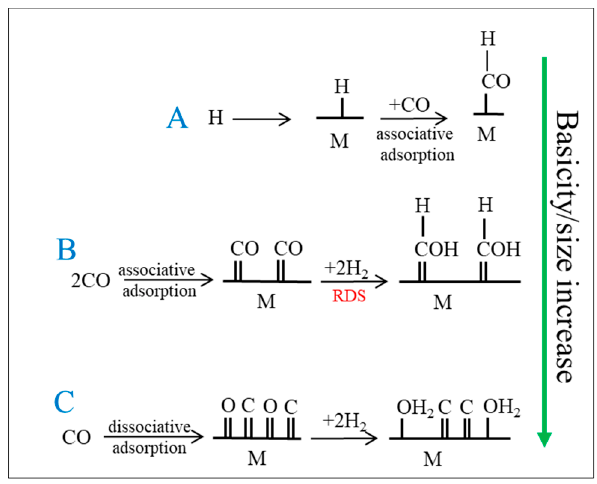
Figure 38. A mechanistic starting point used to describe the effects induced by changes in size and basicity of the alkali promoter on the iron catalyst.